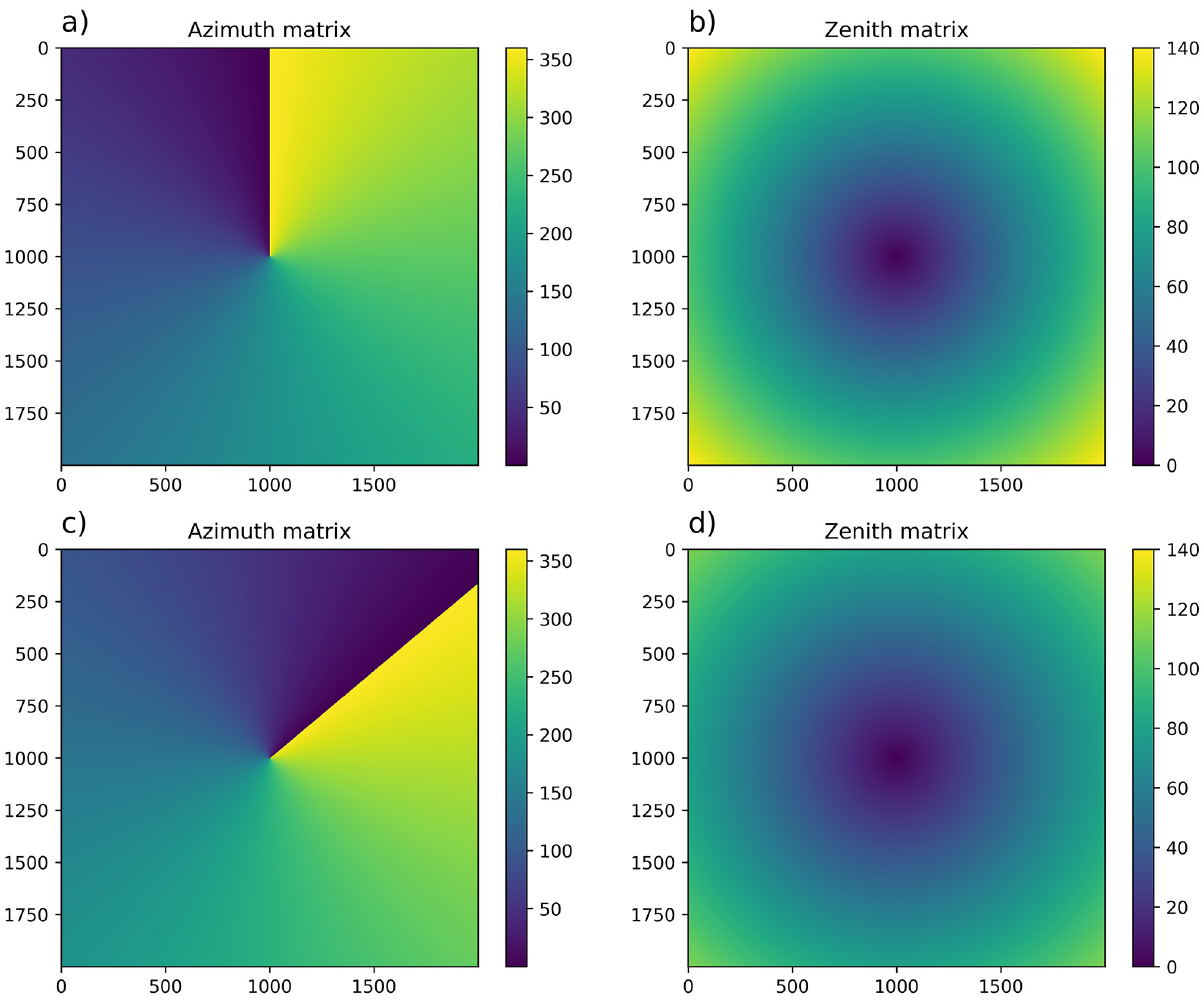
Fig 2. Defaults matrices for azimuth and zenith. a) Shift from north 0˚. b) Extreme zenith 100˚. c) Shift from north -50˚. d) Extreme zenith 80˚.